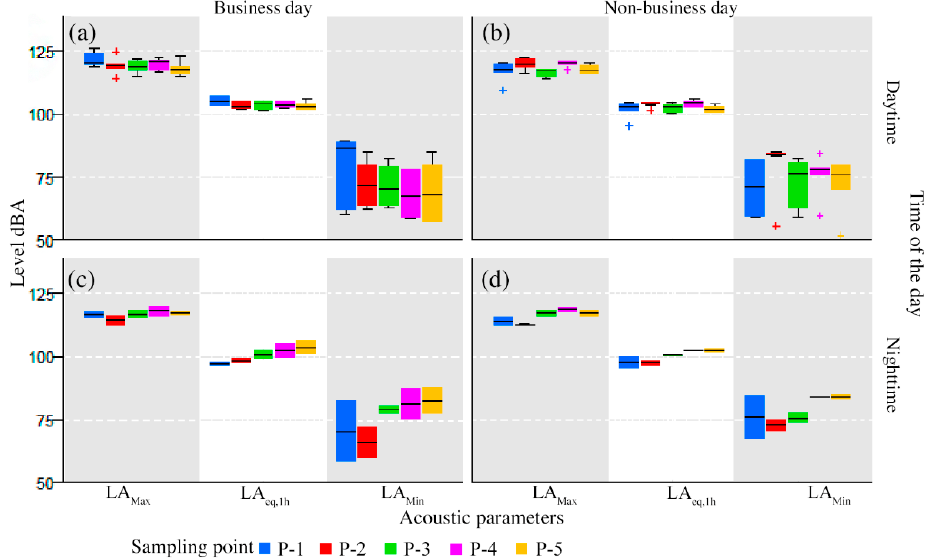
Figure 4. Equivalent, maximum, and minimum noise levels on each day of the week, time of day, and sampling point. ( a ) Weekday, daytime. ( b ) Weekend, daytime. ( c ) Weekday, night-time. ( d ) Weekend, night-time.